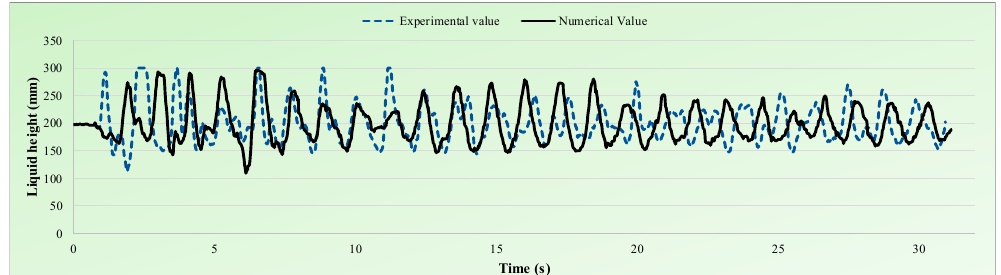
Figure 9. Comparison of experimental and numerical values for water surface at the corner of the tank filled with 200 mm of water and excited by the N-S component of the El Centro earthquake at a 0° orientation.